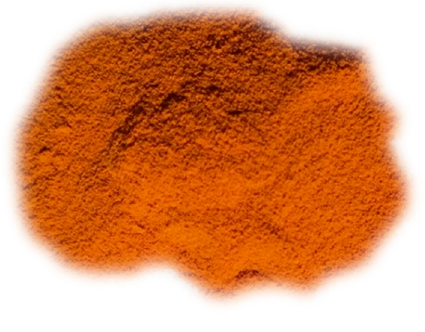
Figure 7. Turmeric powder.